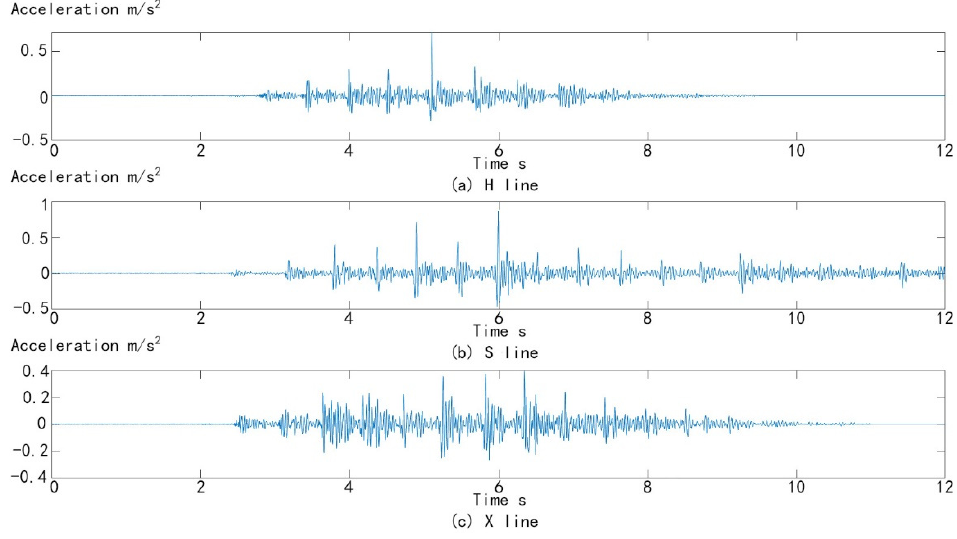
Figure 21. Acceleration response of T5 floor. Table 4. RMS acceleration of the floor under a single person walking load (unit: m/s 2 ).